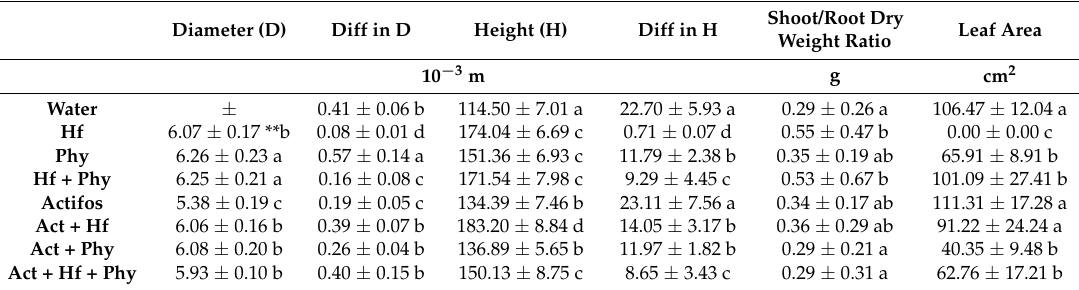
Table 2. Fraxinus excelsior seedling growth characteristics (mean ± SE) for eight treatments at the end of the experiment (September 2017).